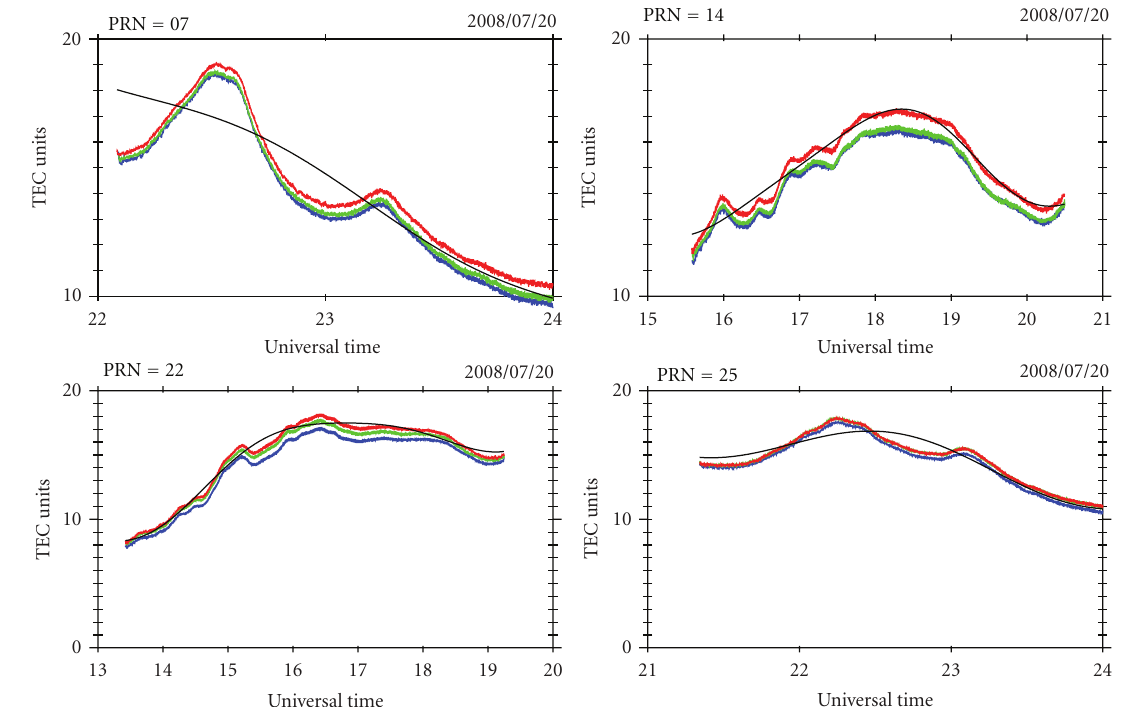
Figure 2: TEC versus UT measured by the Huancayo GPS receivers; red, green, and blue traces represent TEC values from the three receivers; black lines represent the estimated background/unperturbed TEC values. Each of the four panels represents signals from one of four GPS satellites (PRN = 07, 14, 22, and